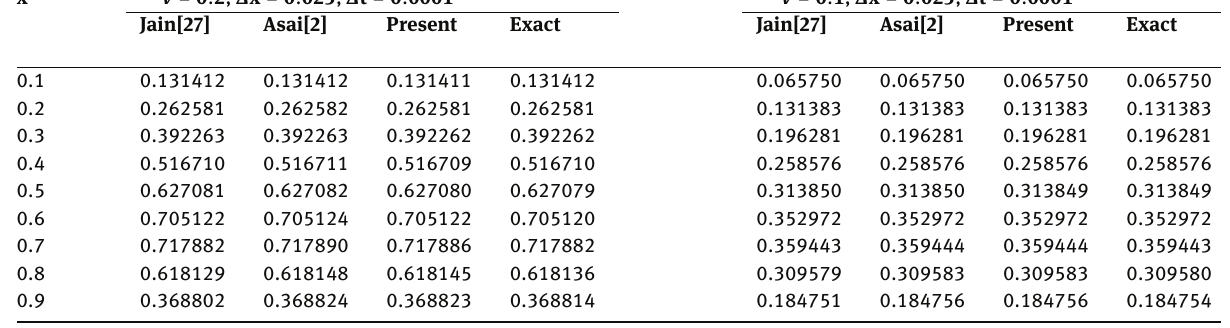
Fig. 10: Physical behavior of numerical solutions of Example 3 at different times in 3D and contour for Δx = 0.0125 , ν = 0.1 at different times with Δt = 0.001 . Table 10: Comparison between exact and existing numerical solutions of Example 3 for ν = 0.2 and ν = 0.1 at different spatial points. x ν = 0 . 2 , Δ x = 0 . 025 , Δ t = 0 . 0001